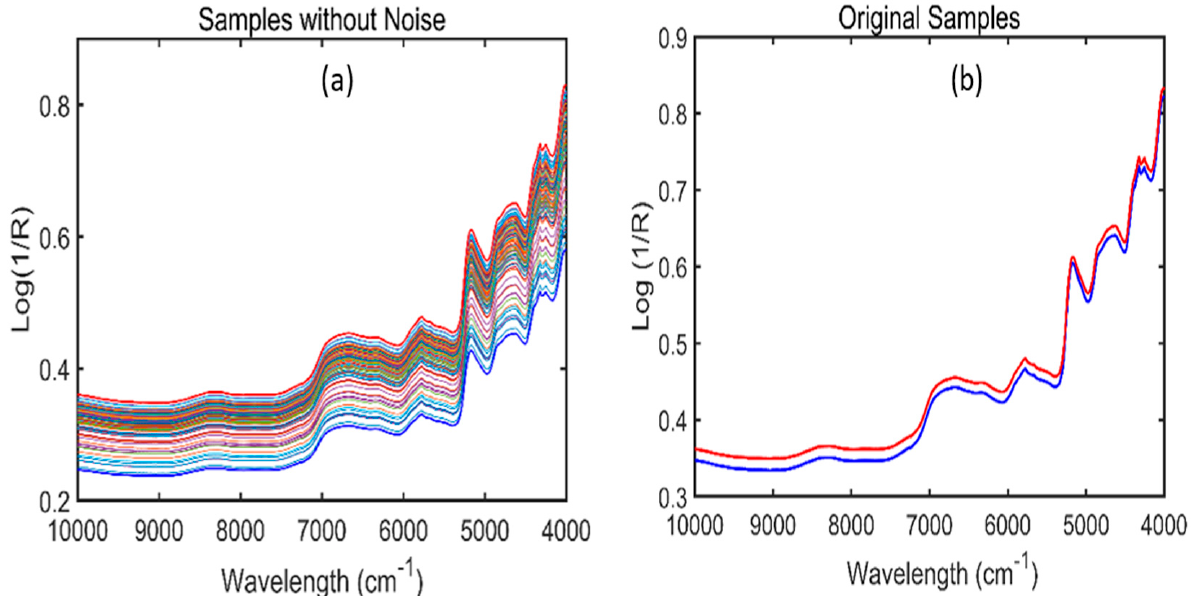
Figure 6. A total of 100 mixed samples FT-NIR spectra of Arabidopsis powder samples for one concentration created by Dirichlet distribution ( a ). FT-NIR spectra developed between two replicates i.e. , white drought_1 and white non-drought_1 (WD_1 and WND_10) for one concentration ( b ).